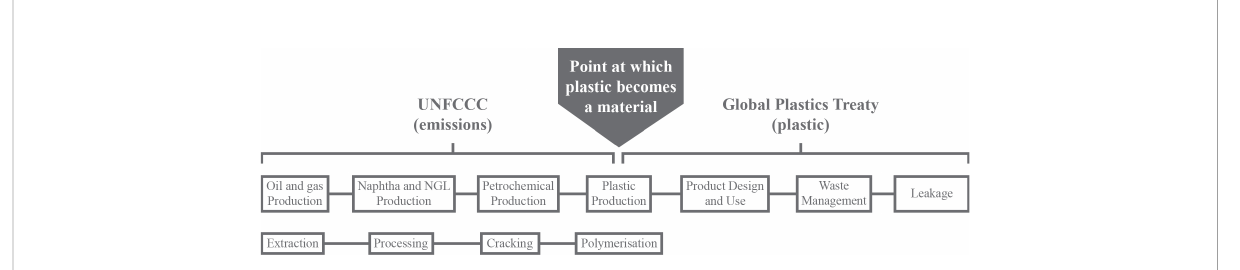
FIGURE 1 A diagram displaying the life cycle of fossil fuels (oil, gas, and coal) in relation to the life cycle of plastics. Polymerisation is the point at which plastics become materials and the minimum stage at which intervention under the incoming treaty needs to begin. However, this should not preclude negotiators from considering measures associated with the extraction of raw materials and sourcing of feedstocks for plastic production and its interlinkages to other